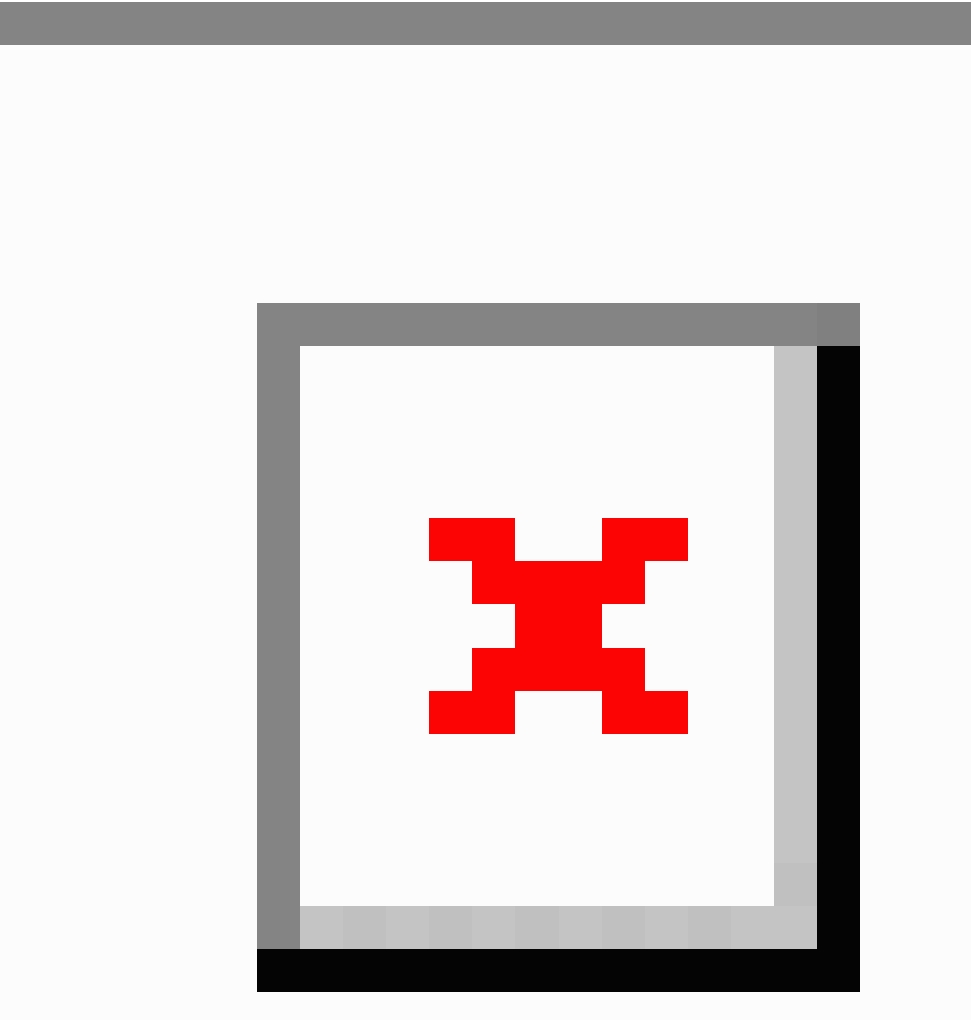
Figure 2. Movement view of the 3-dimensional computer graphic of the shoulder bones and upper